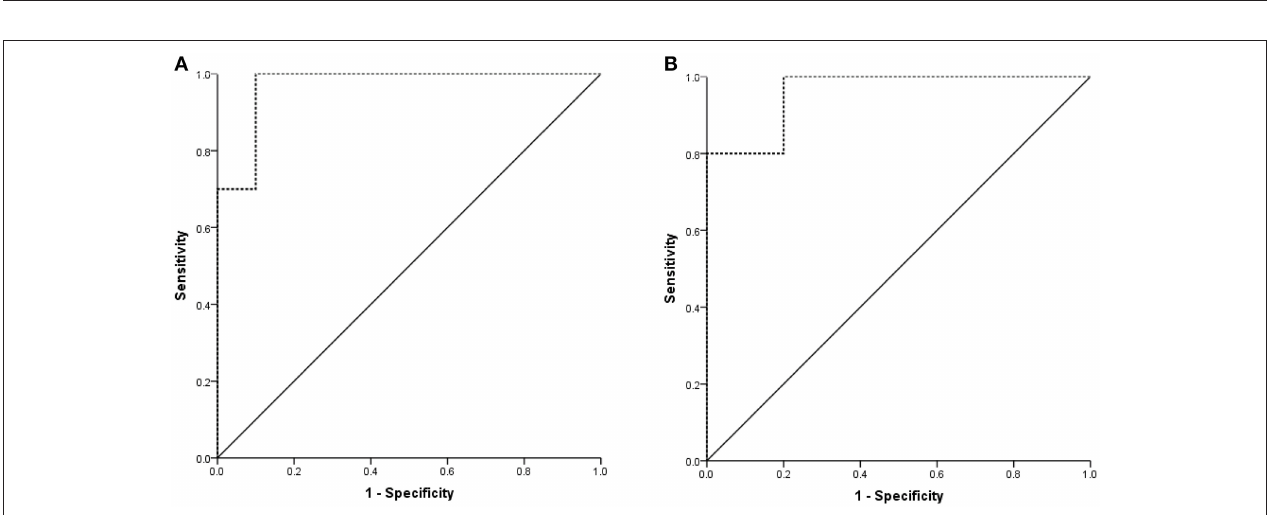
FIGURE 8 | Correlation between the plasma and CSF of levels of exosomal rno-miR-122-5p (A) ( R = 0.632, P < 0.005), rno-miR-300-3p (B) ( R = 0.719, P < 0.001).